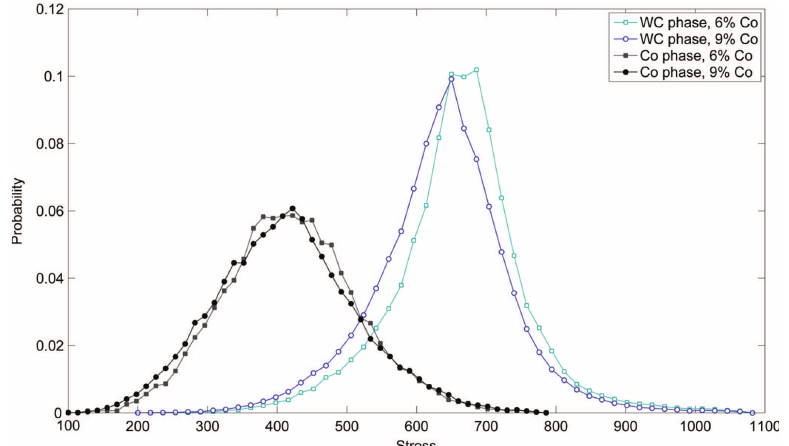
Figure 12: Distributions of the stresses σ 11 in the individual material phases with respect to the cobalt content, 2D model including cobalt islands.